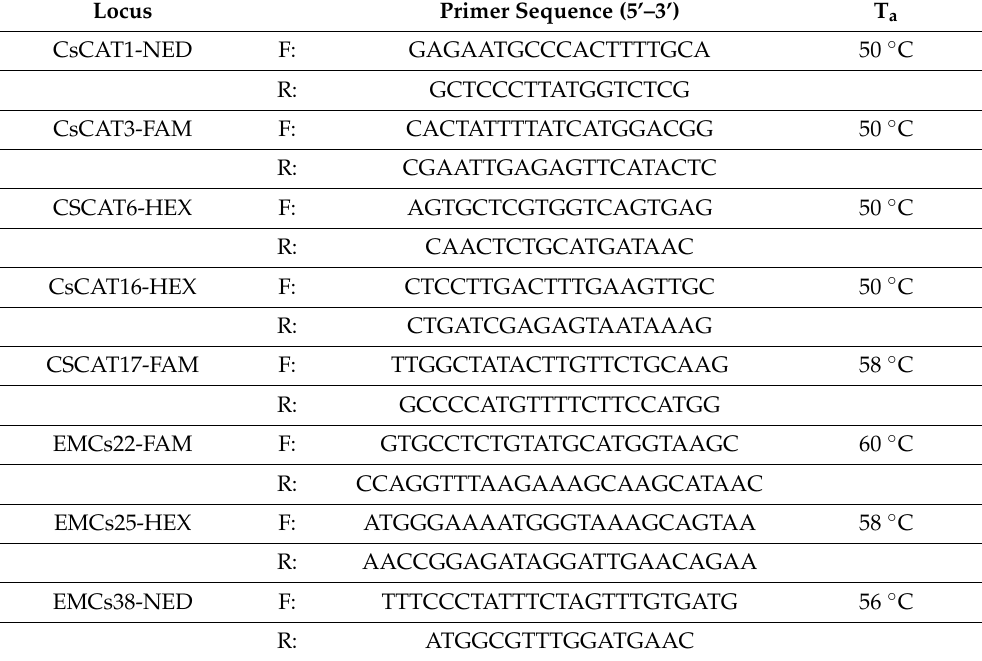
Table 1. Primer sequences and annealing temperatures (T a ) for the eight SSRs used in this study. Locus Primer Sequence (5’–3’) T a